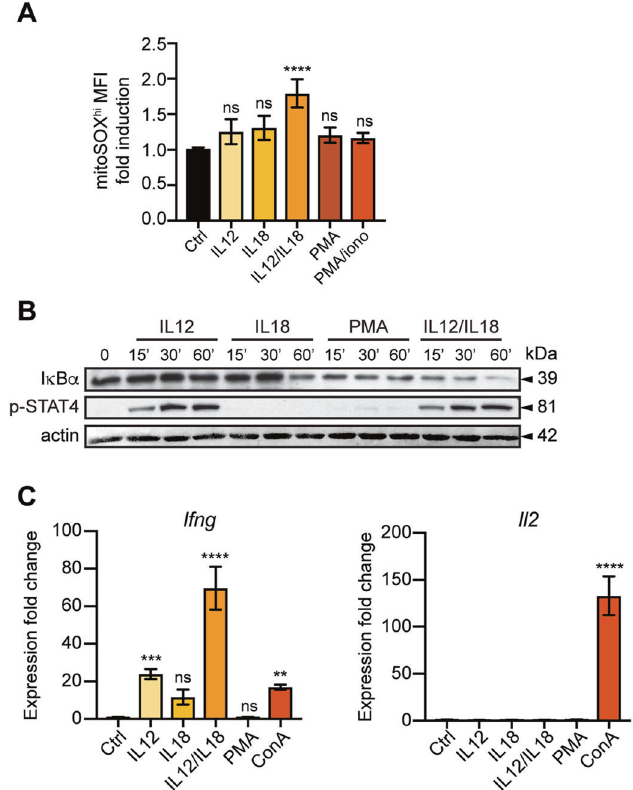
stimuli. B Immunoblot analysis at early time points after treatment with IL-12 alone, IL-18 alone, PMA, or IL-12/IL-18. Shown is representative gel of two experiments performed. β -actin was used as loading control. C qRT-PCR analysis of IFN- γ and IL-2 expression at 1 h after stimulation with different stimuli. All samples were normalized to unstimulated (Ctrl) cells. Graphs show mean ± SD ( n = 3 different mice); **** p < 0.0001; ns not signi fi cant; one-way ANOVA with post-hoc Tukey